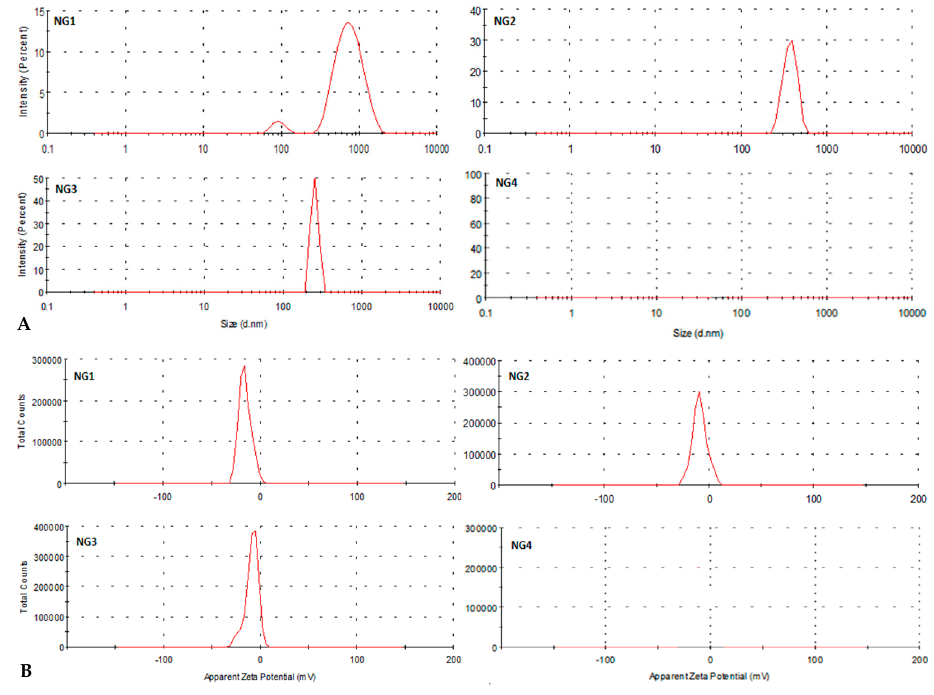
Figure 6. Characterization of different phase states; ( A ) particle size and ( B ) Zeta potential.